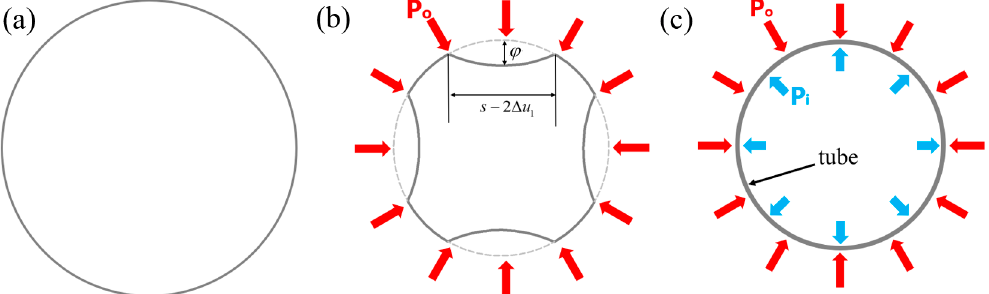
Figure 3. Cross-sectional topography of tube, ( a ) Initial tube, Tube after upsetting ( b ) with wrinkles and ( c ) without wrinkles (from the perspective of the XOZ plane).